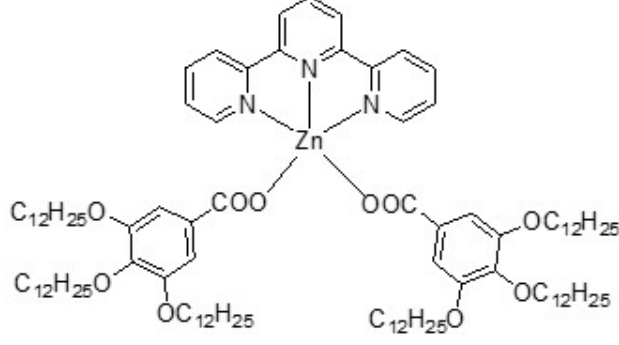
Figure 1. Chemical structure of the complex Zn_MM.